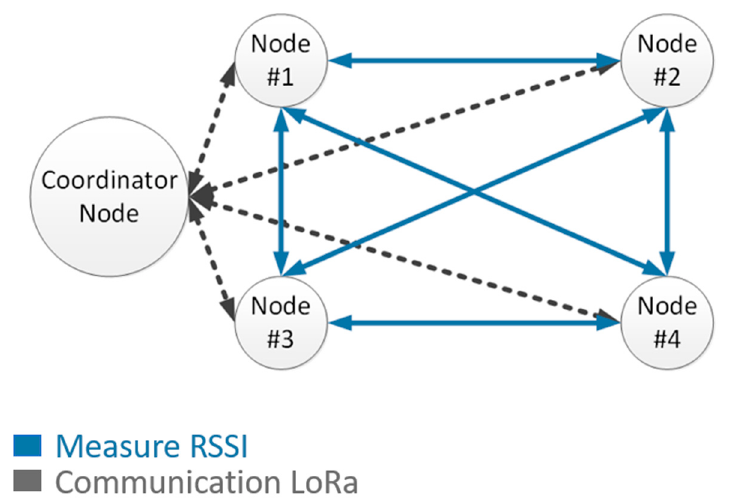
Figure 3. LoRaWAN standard topology.